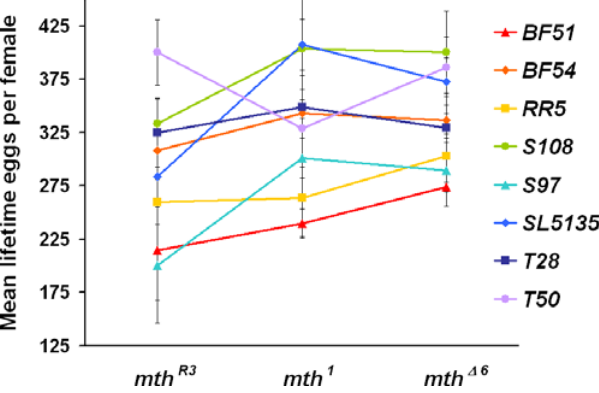
Figure 3. Average lifetime fecundity per line for all genotypic combinations. Non-parallel slopes between lines in the three lab- derived mth backgrounds indicate the functional variation in lifetime fecundity among the wild lines. The general increase in eggs laid across the x-axis represents a correlation of increasing fecundity with decreasing background mth expression; all lines but T50 showed lowest fecundity when paired with the wild-type mth R3 allele. Error bars show 95% confidence.